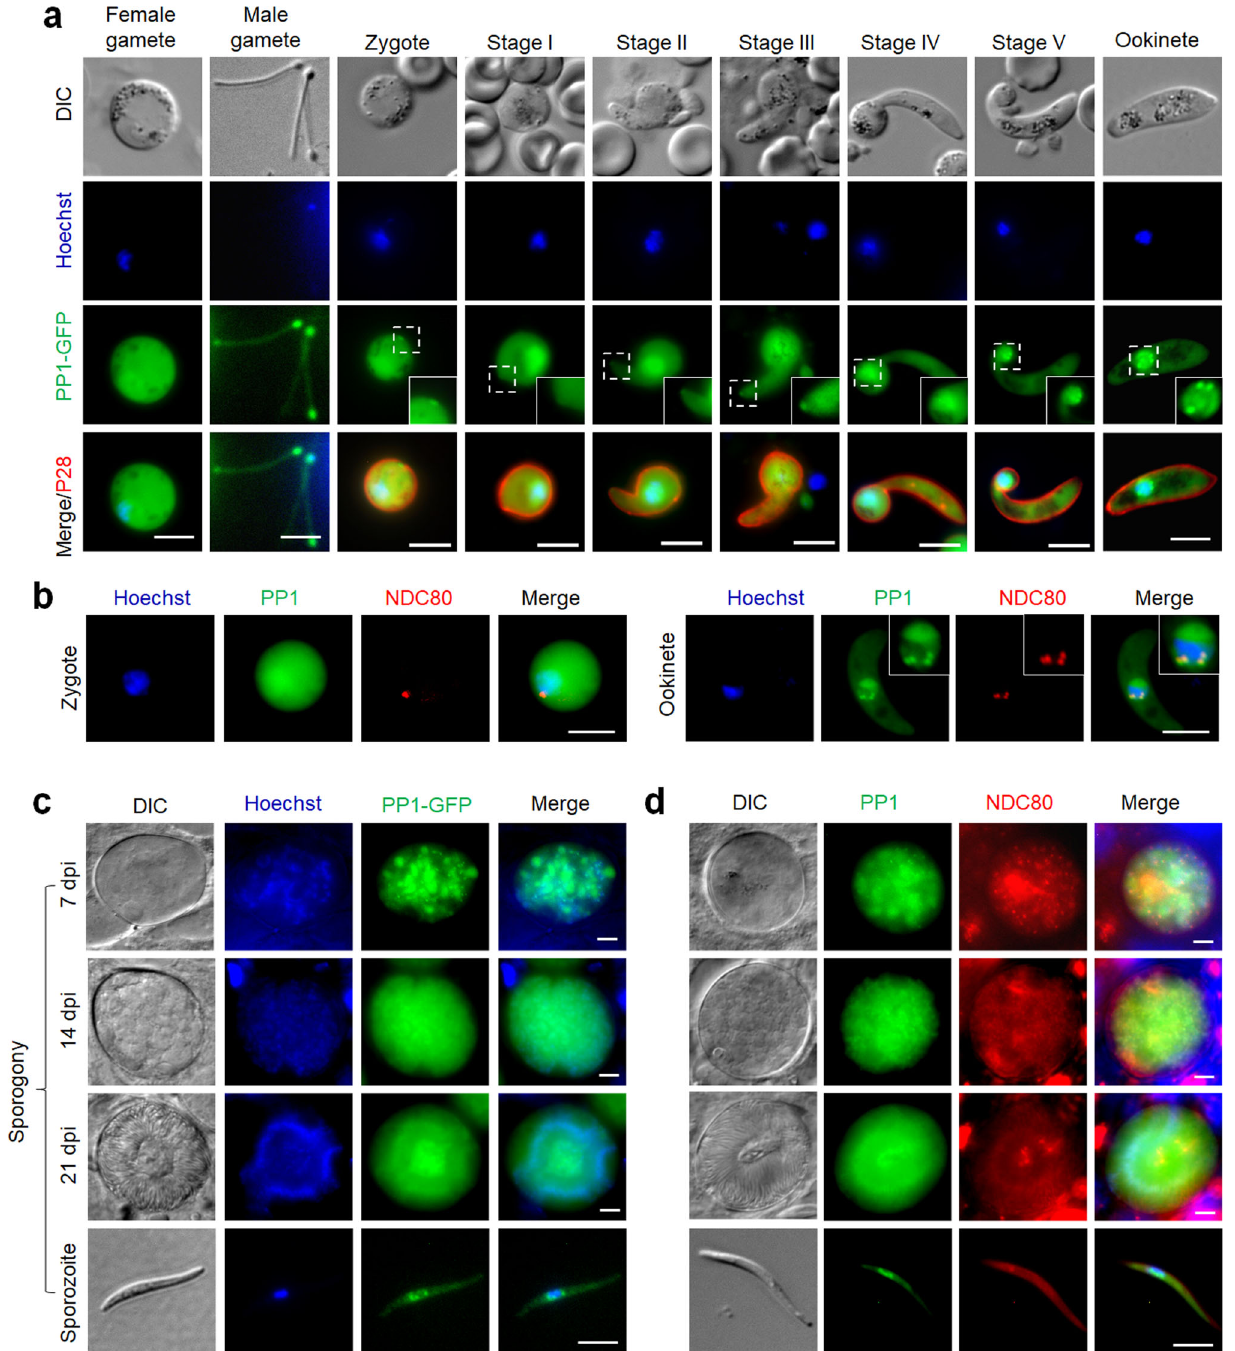
Fig. 3 PP1-GFP localisation during zygote formation, ookinete development and sporogony inside the mosquito gut. a Live-cell imaging showing PP1-GFP location in male and female gametes, zygote and during ookinete development (stages I – V and mature ookinete). A cy3-conjugated antibody, 13.1, which recognises the P28 protein on the surface of zygotes and ookinetes, was used to mark these stages. Panels: DIC (differential interference contrast), PP1-GFP (green, GFP), 13.1 (red), Merged: Hoechst (blue, DNA), PP1-GFP (green, GFP) and P28 (red). Scale bar = 5 μ m. Insets show, at higher magni fi cation, the PP1-GFP signal on the zygote and developing apical end of early stage ‘ retorts ’ , and in the nucleus of late retorts and ookinete stage. b Live-cell imaging of PP1-GFP (green) in relation to NDC80-mCherry (red) and Hoechst staining (blue, DNA) in zygote and ookinete stages. c Live-cell imaging of PP1-GFP in developing oocysts in mosquito guts at 7-, 14- and 21-days post-infection and in a sporozoite. Panels: DIC, Hoechst (blue, DNA), PP1- GFP (green), Merged (blue and green channels). d Live-cell imaging of PP1-GFP in relation to NDC80 in developing oocysts and in a sporozoite. Panels: DIC (differential interference contrast), PP1-GFP (green), NDC80-mCherry (red), Merge (Hoechst, blue, DNA; PP1-GFP, green; NDC80-mCherry, red). In all panels, scale bar = 5 µ